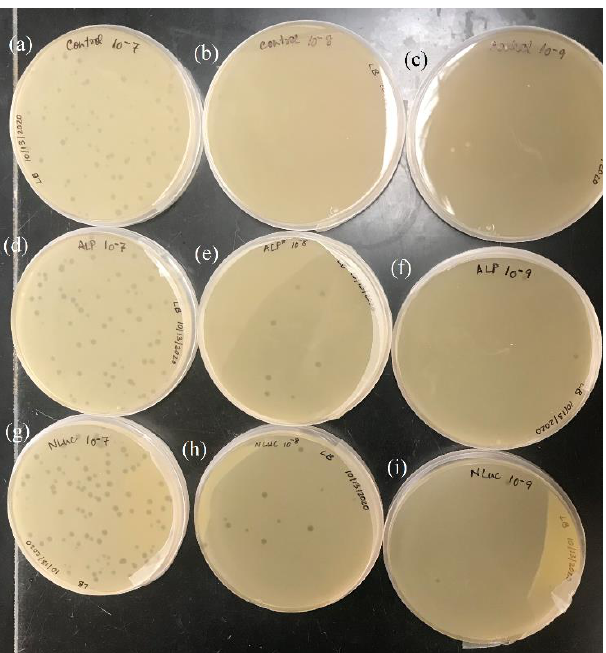
Figure A1. Plaques produced by Control phage ( a-c ), ALP* phage ( d-f ), and NLuc phage ( g-i ). Each row is dedicated to a recombinant phage and the three dilutions used for each phage (10 −7 PFU/mL to 10 −9 PFU/mL) show from left to right.